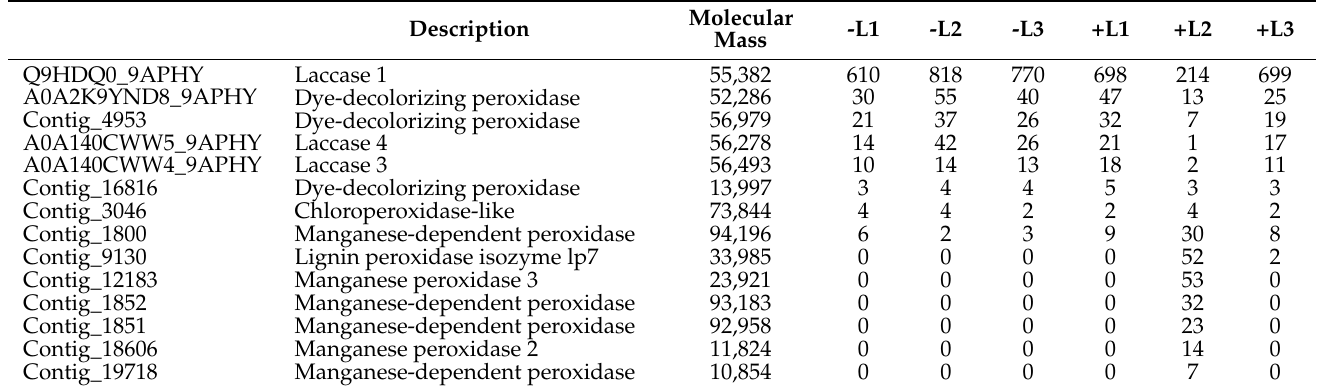
Table 1. Putative laccase and peroxidases potentially identified in Coriolopsis gallica grown in the presence (+L) or absence (-L) of levofloxacin modification, and their abundances assessed based on spectral counts.